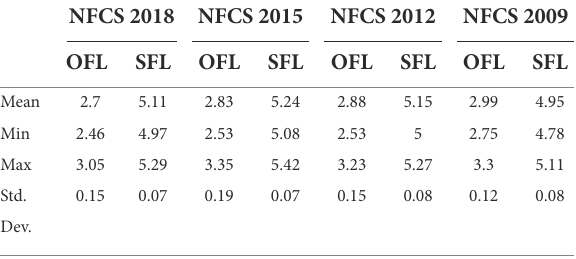
TABLE 3 The statistics of within-state average.